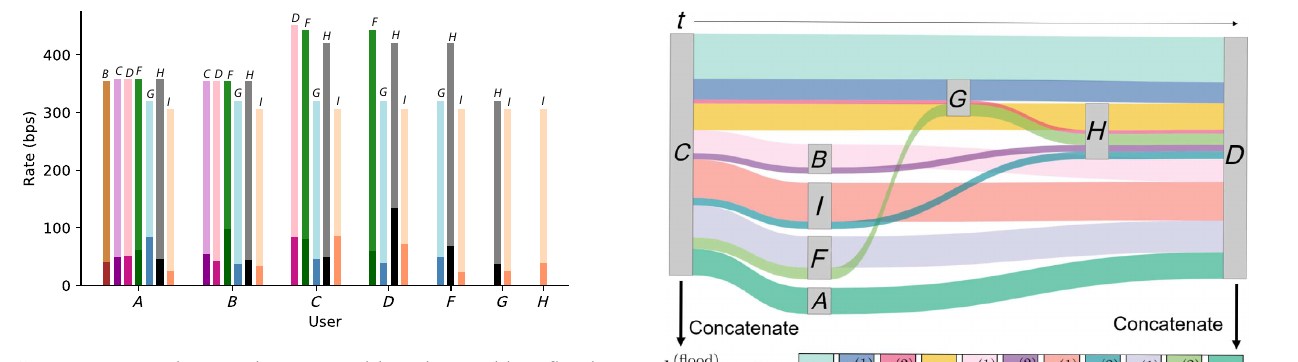
FIG. 7. Improved secure key rates with end-to-end key flood- ing on our eight-user quantum network test bed. The direct key rates (bold colors) and the flooding secure key rates (lighter col- ors) are shown between every pair of end users in the experiment (labels above the bar indicate the user connected to). Using the flooding protocol, a fully connected network can be made exactly equivalent to an access network with improved rates, where an optical switch chooses which end users can communicate at any instant.